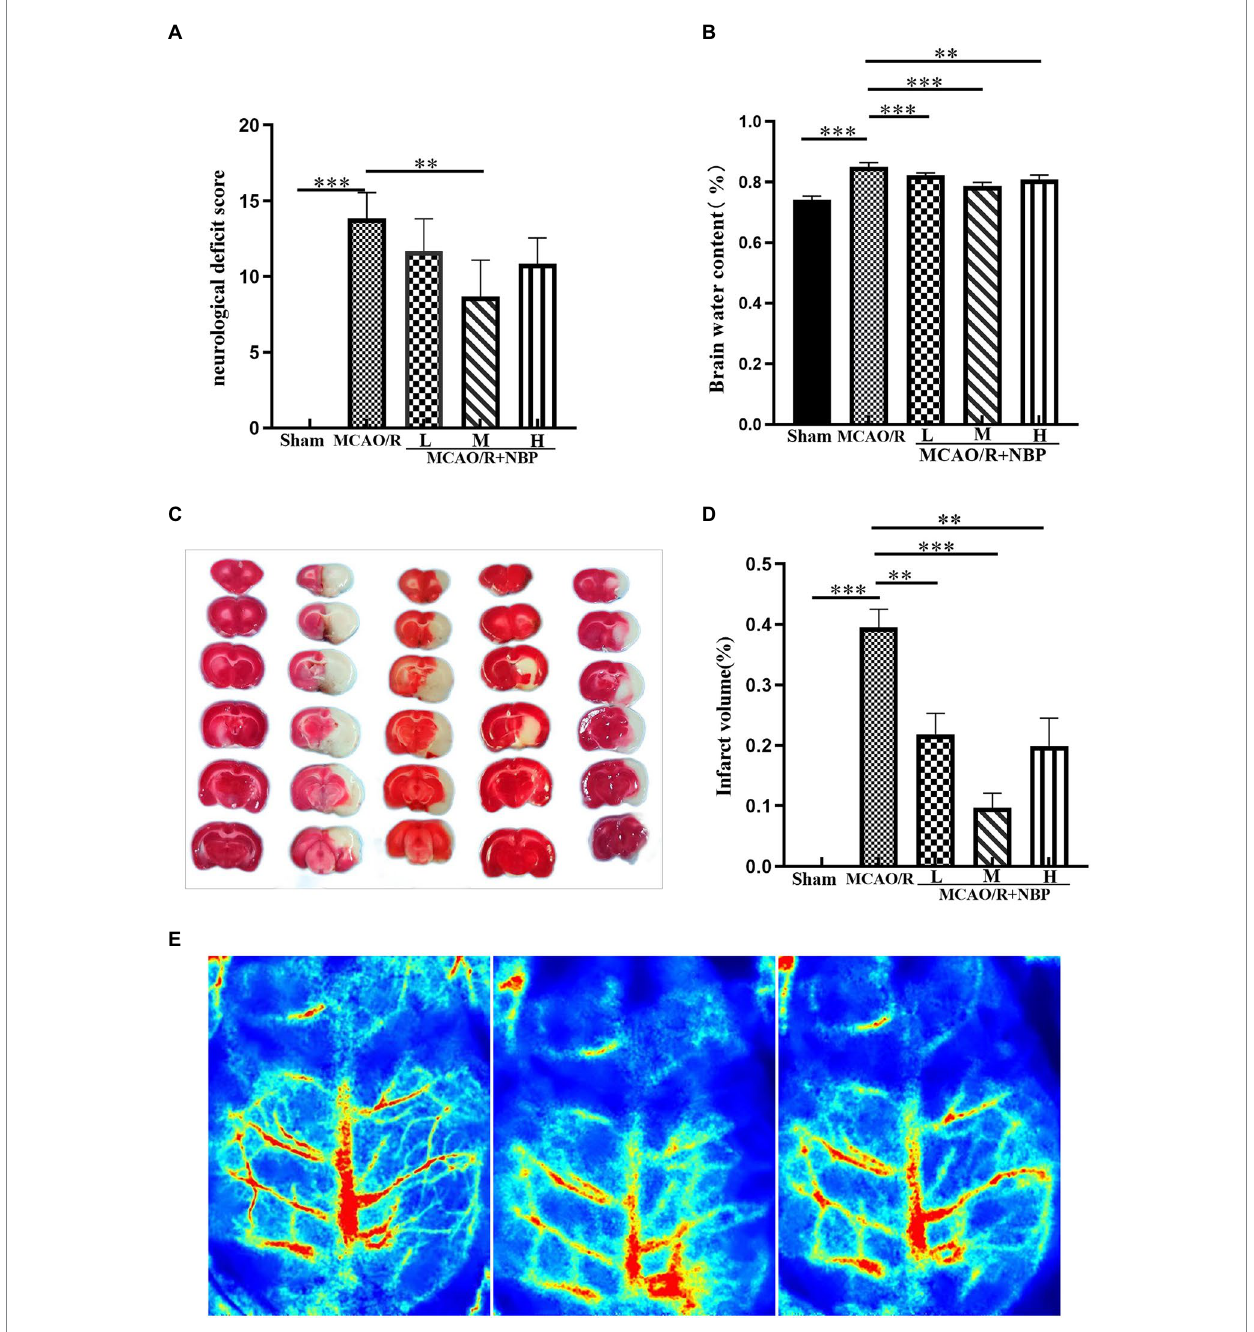
FIGURE 1 Effects of NBP on neurological deficit scores, brain water content, and cerebral infarct area. (A) Neurological deficit score. (B) Brain water content. (C) TTC staining. (D) Infarct volume. (E) Cerebral Blood Flow Measurement (From left to right, normal, ischemia and reperfusion). MCAO, middle cerebral artery occlusion; NBP, N-butylphthalide; TTC, 2,3,5-Triphenyltetrazolium chloride; MCAO/R + NBP-L, Low-dose N-butylphthalide, 10 mg/kg; MCAO/R + NBP-M, Medium-dose N-butylphthalide, 20 mg/kg; MCAO/R + NBP-H, High-dose N-butylphthalide, 30 mg/kg. * p < 0.05; ** p < 0.01; *** p < 0.001. The values represent the mean ± SD, n =